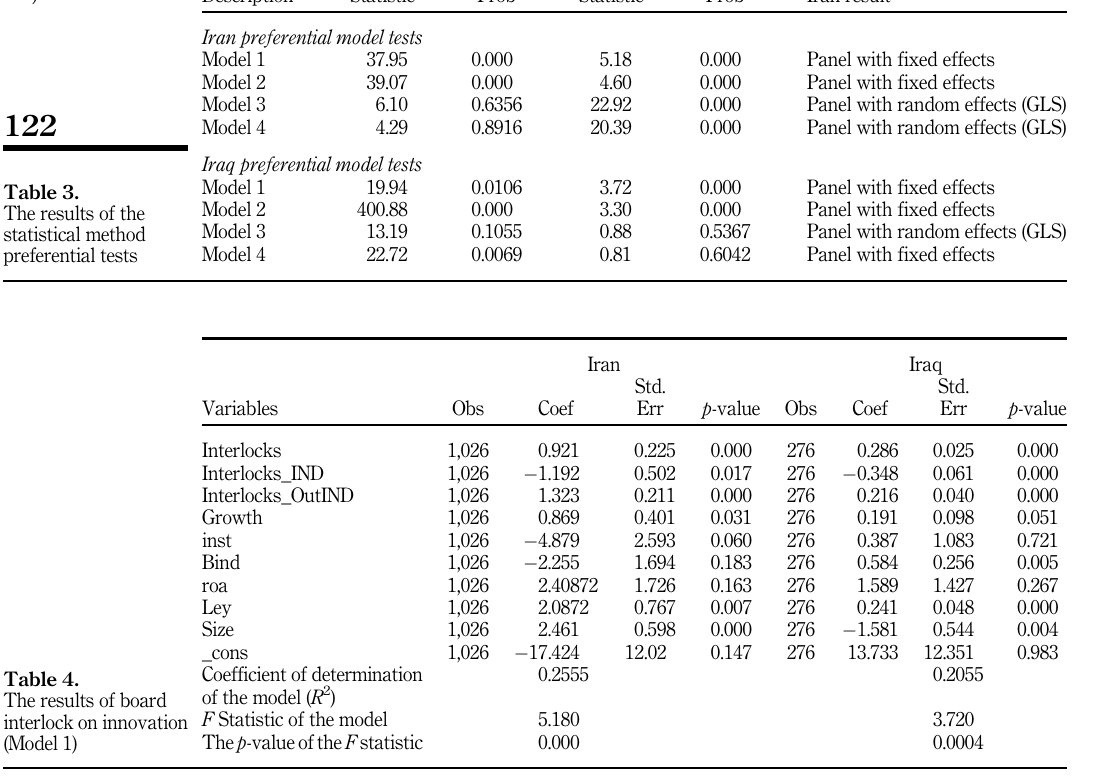
Table 4. The results of board interlock on innovation (Model